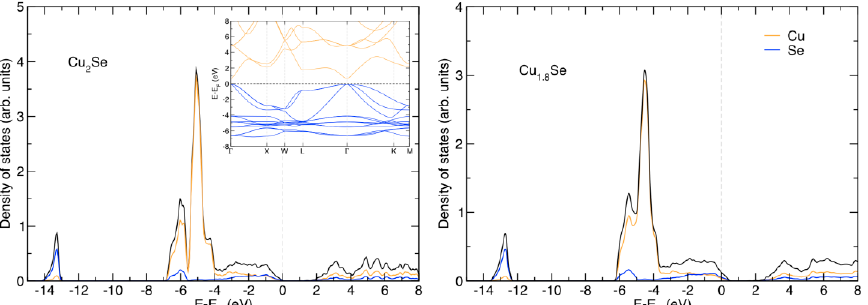
Figure 7. The calculated band structure and density of states (DOS) of Cu 2 Se and the DOS of Cu 1.8 Se. The band structure plot has the valence bands represented by blue color while the conduction bands are given in yellow. For the DOS figures, the total DOS is given by the black line, while the projected DOS for Cu and Se is given in yellow and blue, respectively. The energies are given with respect to the Fermi level, EF.